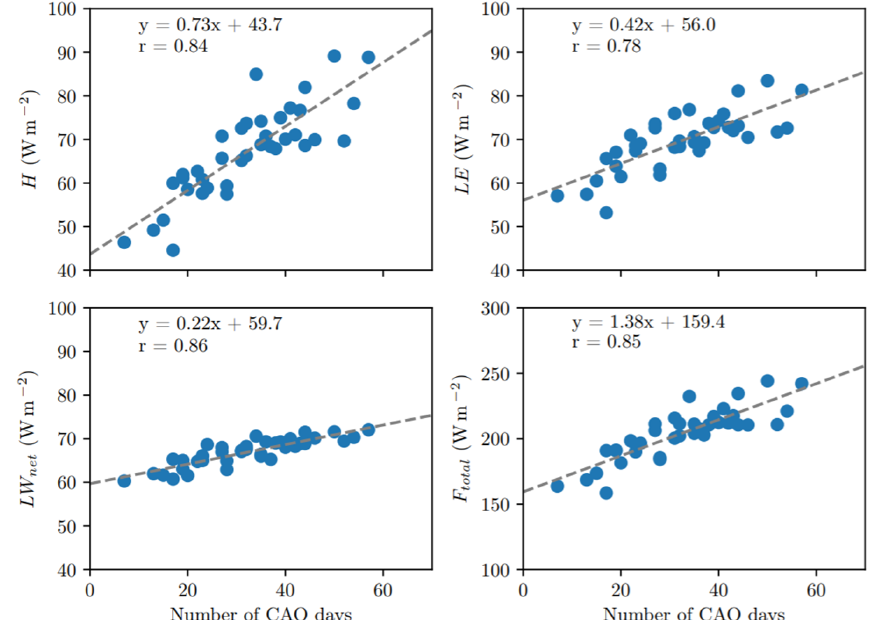
Figure 9. Turbulent fluxes of sensible and latent heat ( H and LE , respectively), net longwave radiative flux (LW net ) and the total heat flux ( F total ) averaged over the cold season (November–April) and over the ice-free part of the Barents Sea as a function of number of CAO days during the same period for 1979–2018. The dashed line shows the linear regression line, whose equation is given in each plot, as well as the correlation coefficient ( r